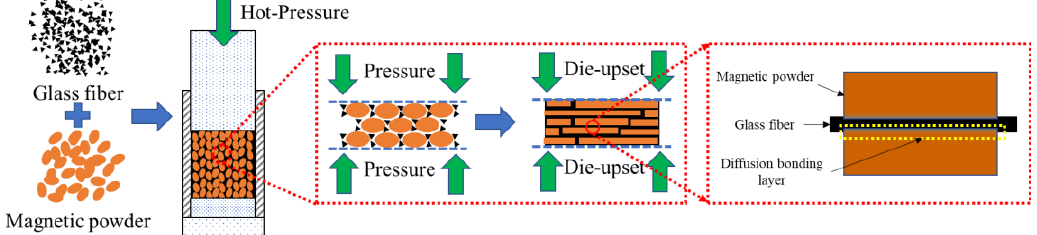
Figure 8. Schematic of the preparation process of the magnets with glass fiber.